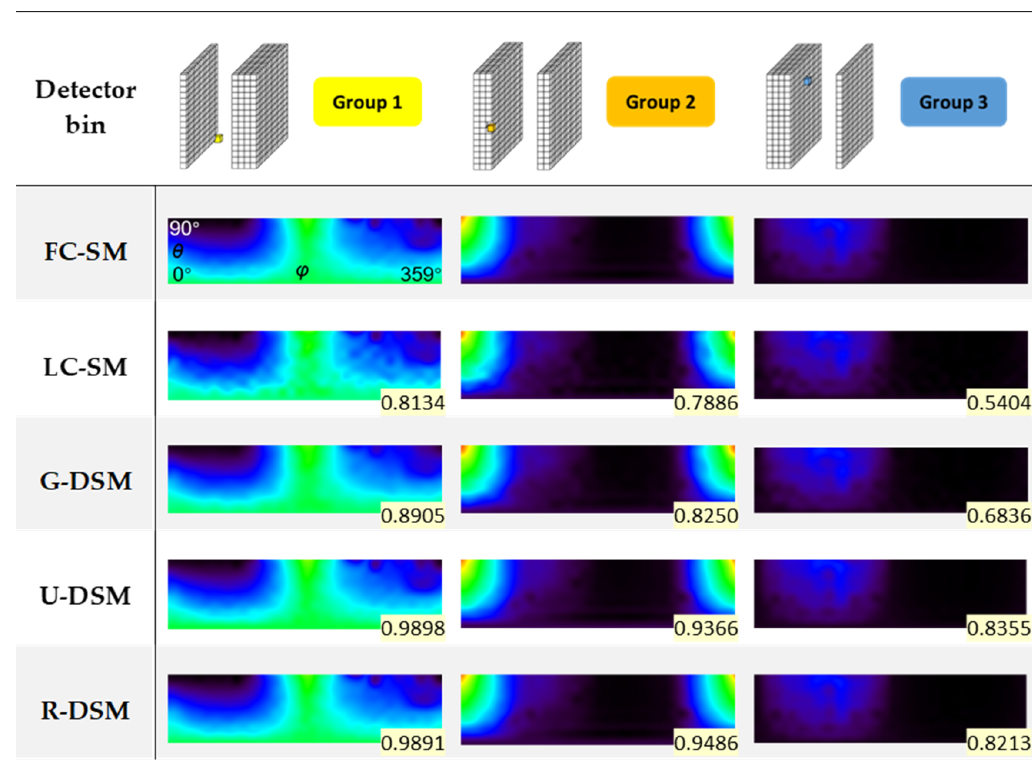
Figure 10. Representative DRF images of FC-SM, LC-SM, G-DSM, U-DSM, and R-DSM for 99m Tc source. SSIM value between each DRF image and FC-SM case is given in the bottom-right corner.